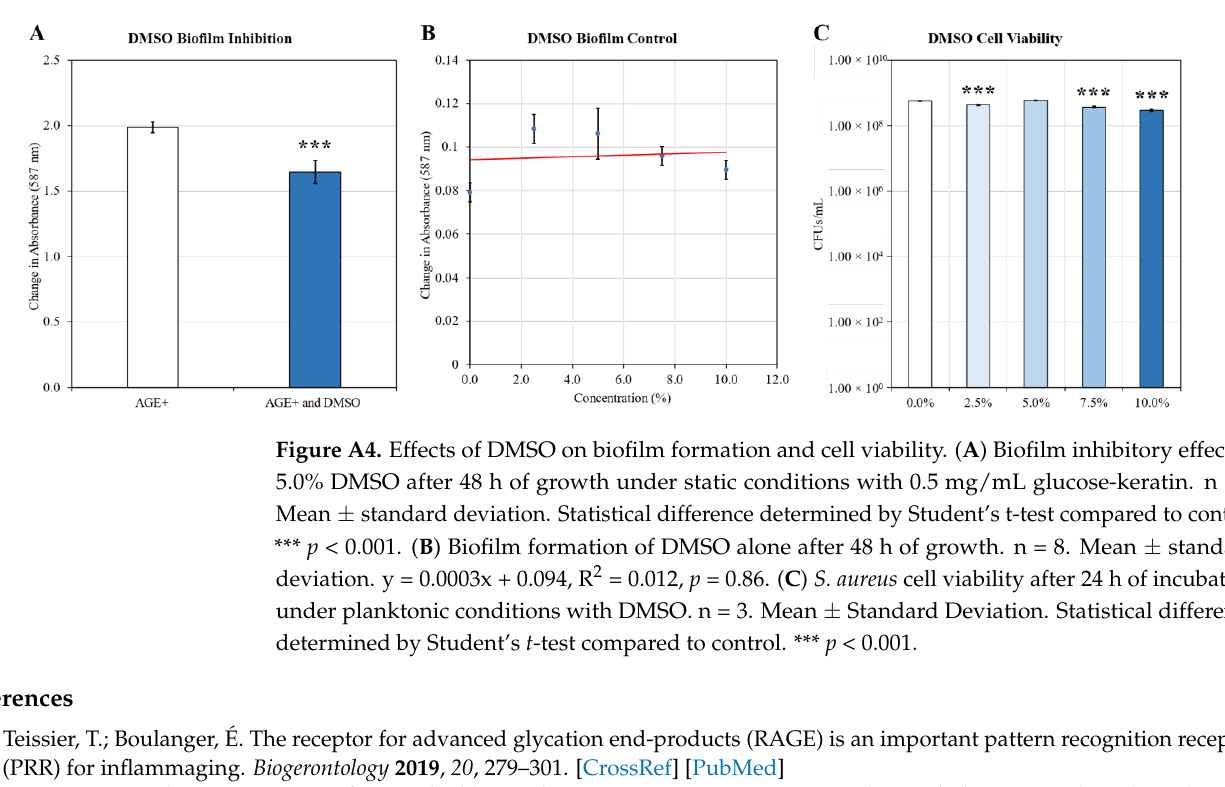
Mean ± standard deviation.